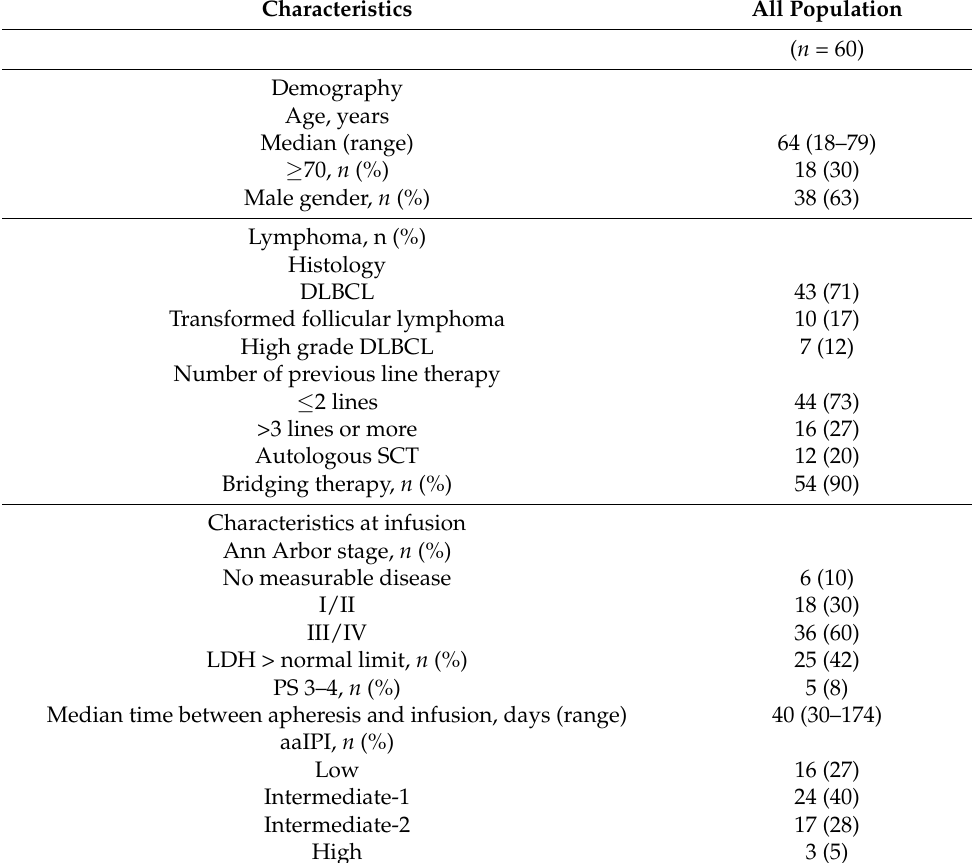
Table 1. Baseline characteristics of